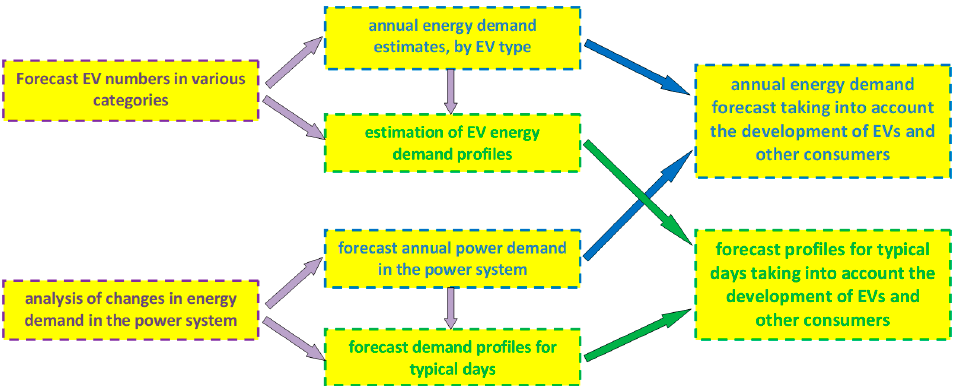
Figure 4. General diagramme of studies described in this